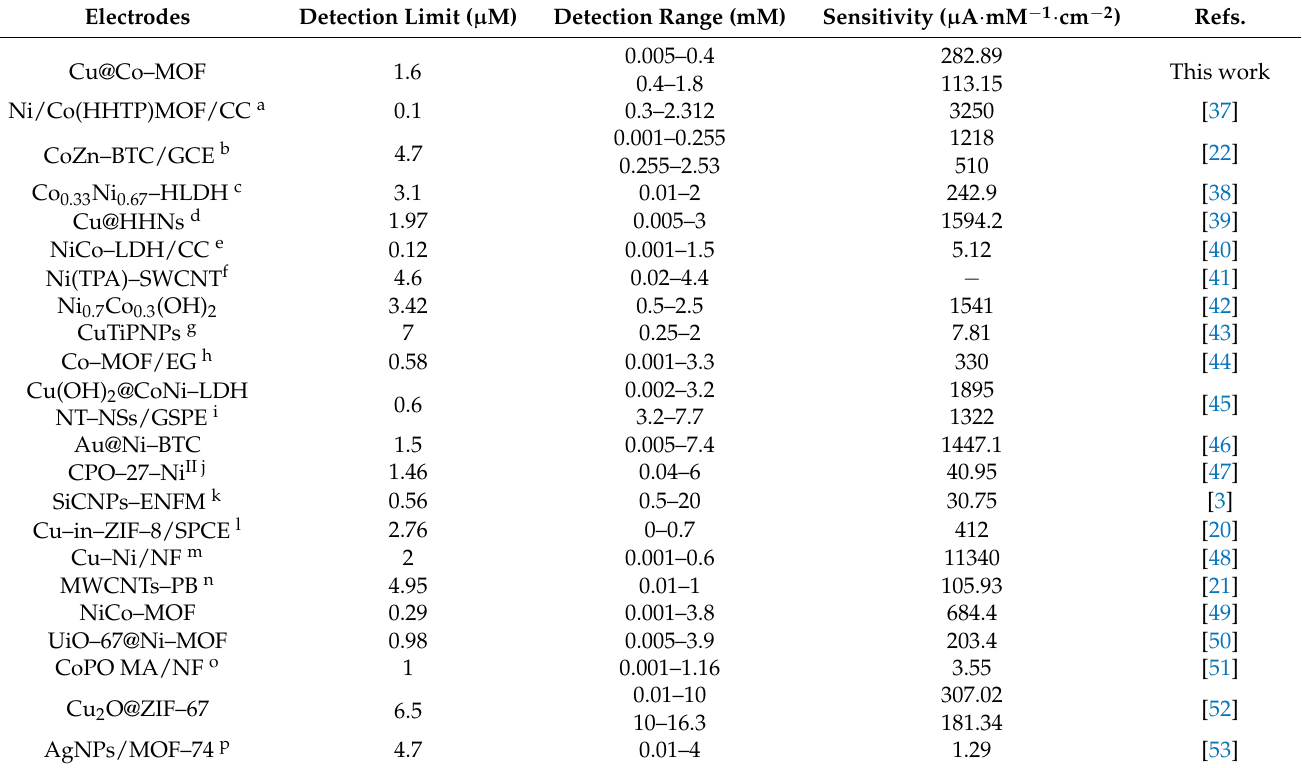
Table 1. Comparison of detection performances of reported non–enzymatic electrochemical Glu sensors with